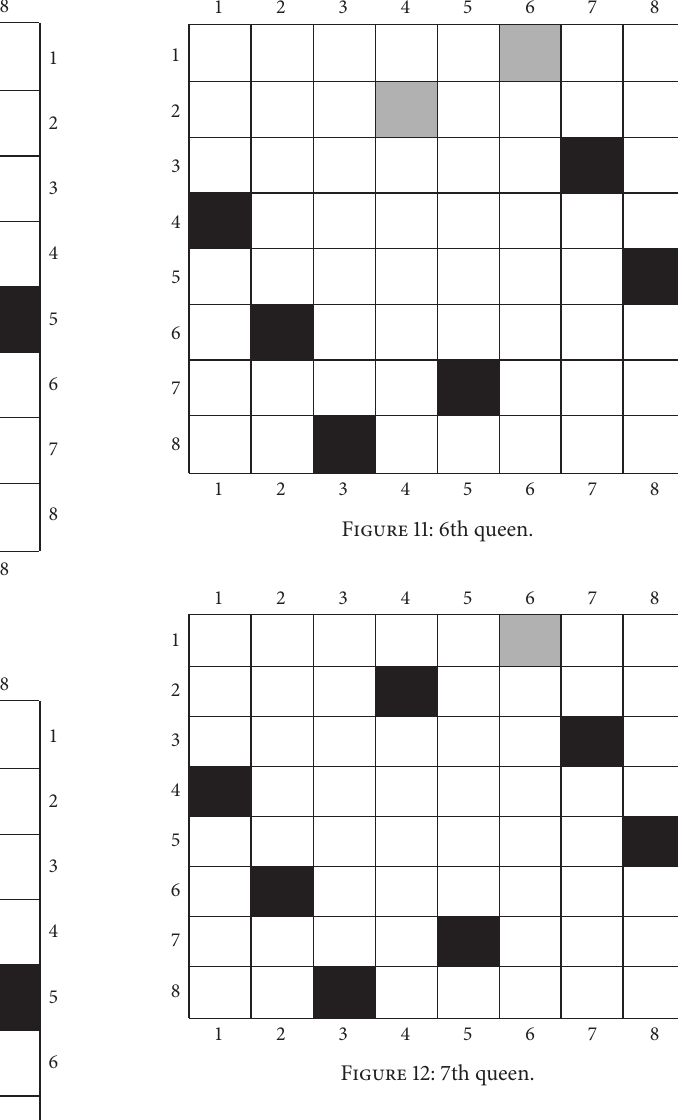
Figure 11: 6th queen.